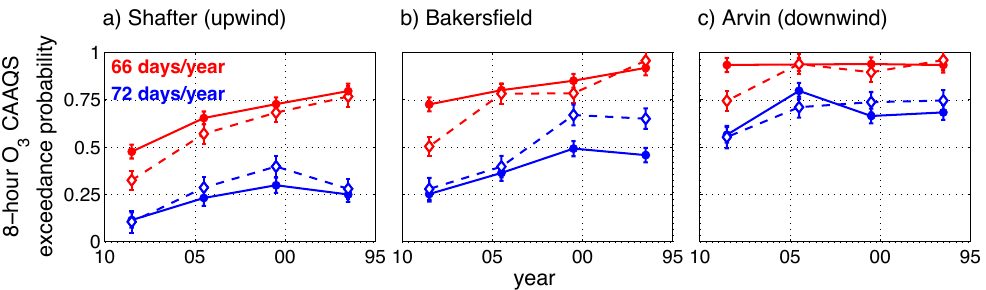
* 7 2 CAAQS vs. year 3 3